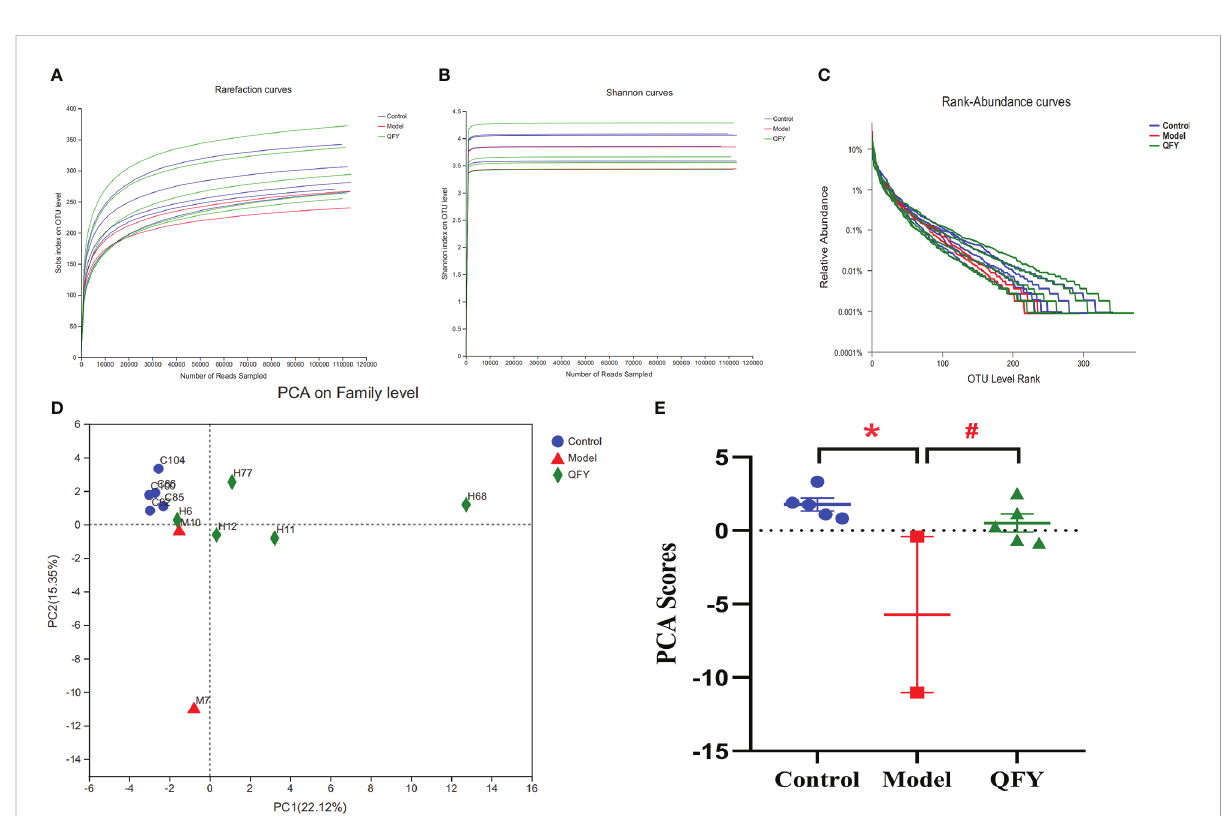
FIGURE 5 Effects of Qi-Fu-Yin on the number and diversity of gut microbiota species in APP/PS1 transgenic mice. (A) Alpha diversity analysis of species abundance, (B) Alpha diversity analysis of diversity, (C) Rank-Abundance analysis of species richness and community evenness, (D) PCA on the Family level, the fi rst two principal coordinates PC1 and PC2 are plotted. (E) PCA scores according to the sample coordinates. Mean ± SEM, n=2~5, * P <0.05, unpaired Student ’ s- t test with one-tailed. GraphPad Prism 8.0.1